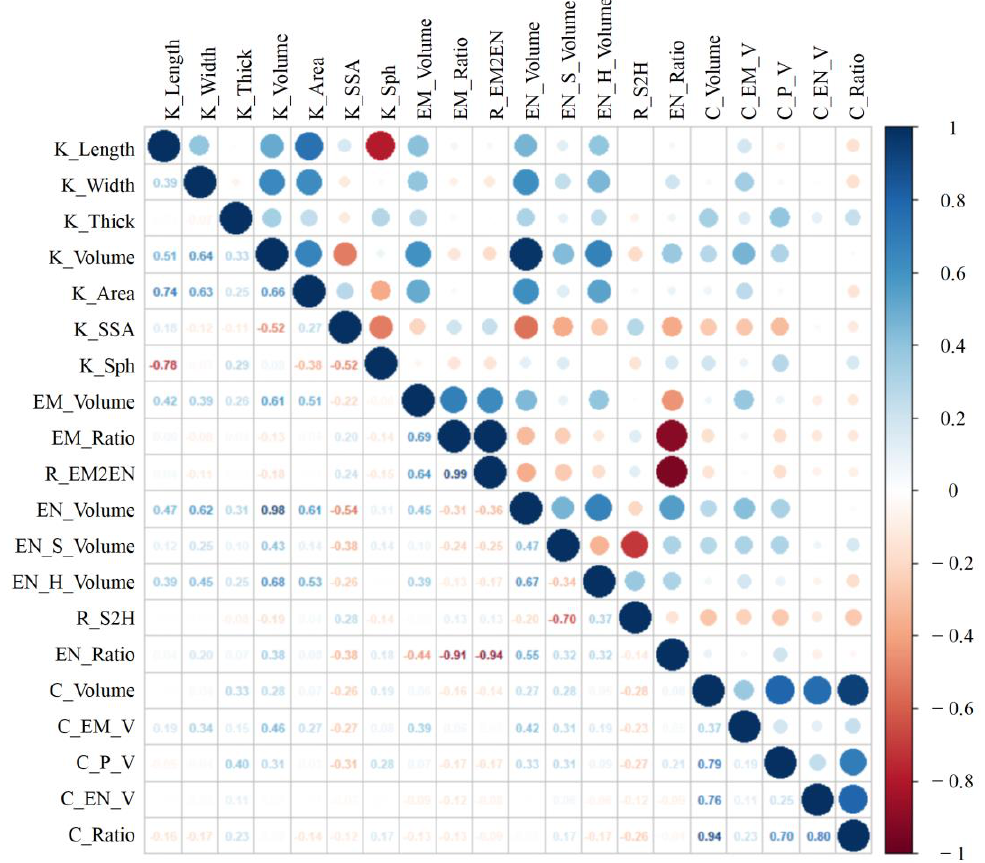
Figure 4. Correlation analysis of kernel phenotypic traits.